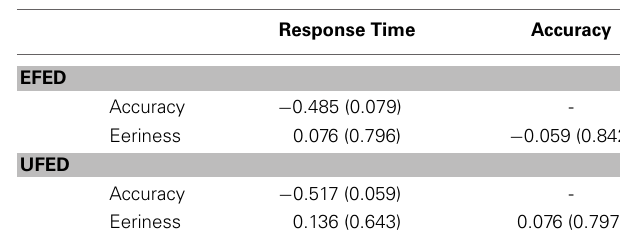
Table 2 | Pearson correlations of dependent measure in the test phase for equal frequency (EFED) and unequal frequency conditions